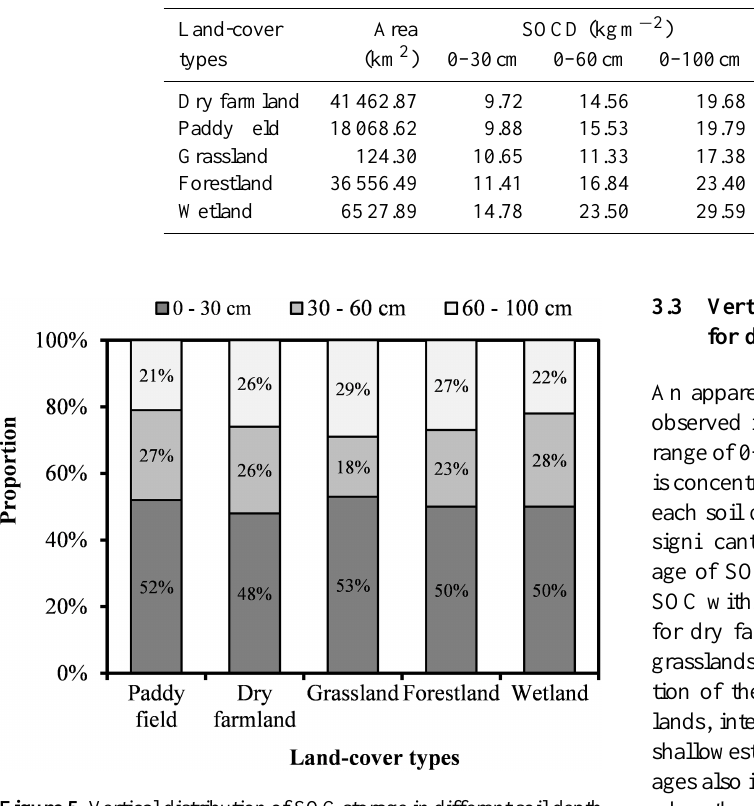
Figure 5. Vertical distribution of SOC storage in different soil depth ranges for various land-cover